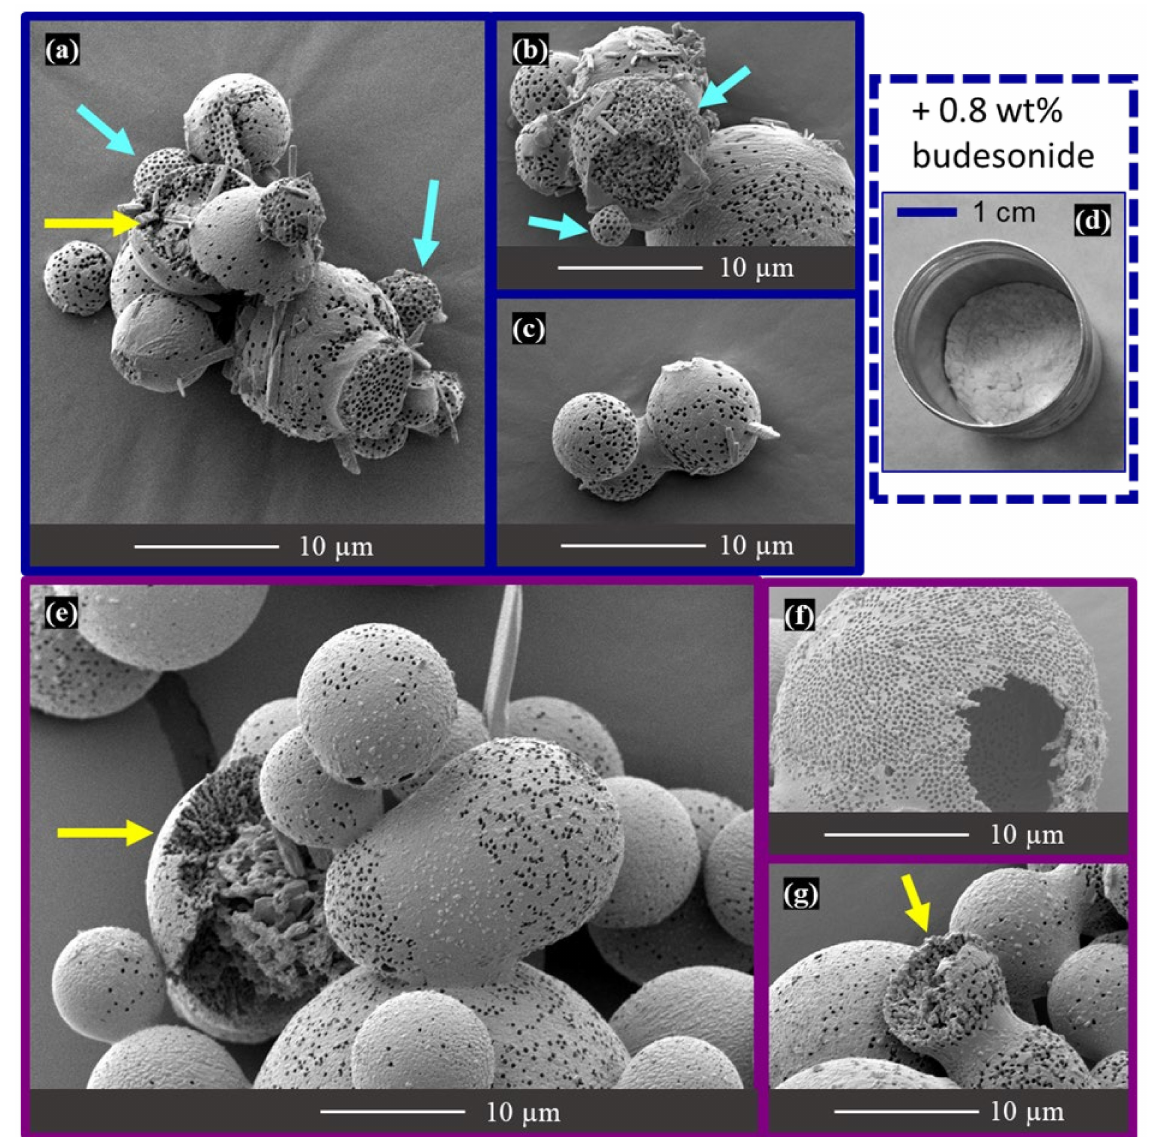
Figure 9. ( a – c , e – g ) The SEM micrographs of etched granules prepared for the M:PS ratio = 1:1 com‑ position in the Niro pilot‑scale spray dryer with the rotary nozzle; ( d ) photograph of the formulation after mixing with the budesonide API. Figures corresponding to granules collected at the bottom of the cyclone or at the bottom of the drying chamber are outlined in dark blue and dark pink, respec‑ tively. The arrows highlight examples of granule microstructures discussed in the